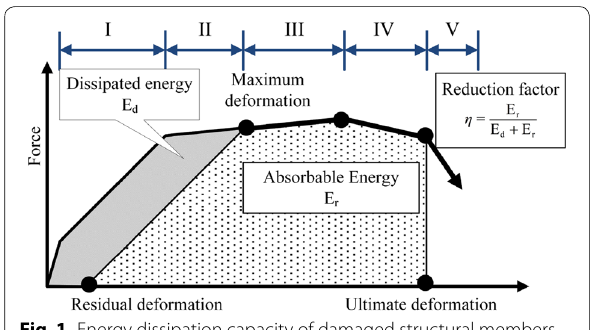
Fig. 1 Energy dissipation capacity of damaged structural members. (JBDPA